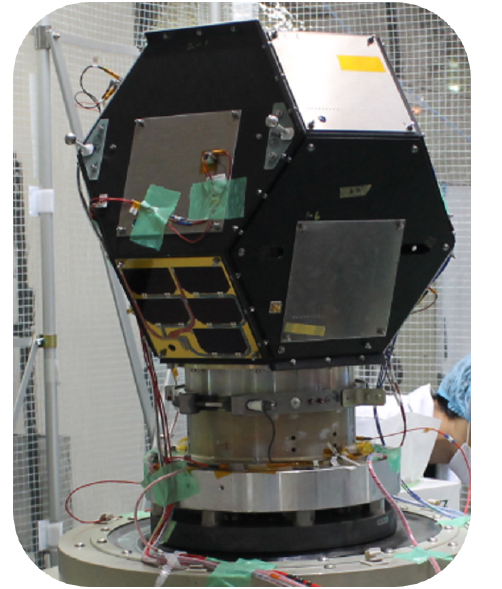
Figure 8. SMIC setup in Ten-Koh STM during